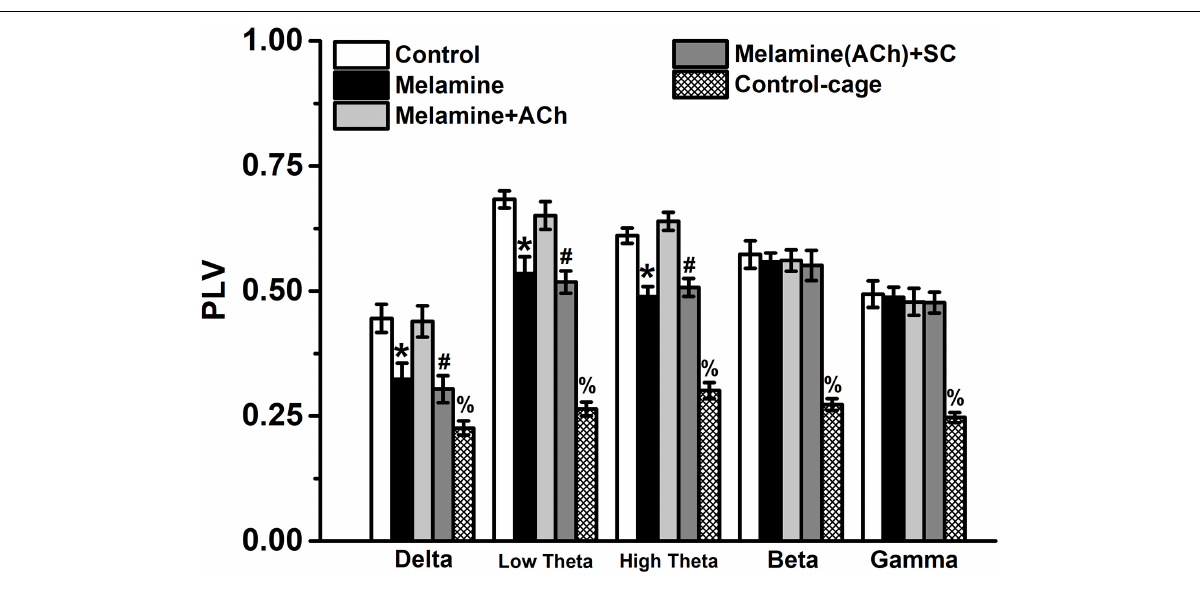
FIGURE 3 | The phase locked value (PLV) between the CA3 and CA1 regions. The PLV was significantly declined comparing melamine to the control group. Injection of acetylcholine (ACh) into the hippocampus (HPC) effectively enhanced the PLV index. * P < 0.05, melamine vs. control, melamine+ACh, and control cage; # P < 0.05, melamine(ACh)+SC vs. control, melamine+ACh, and control cage; % P < 0.05, control cage vs. other